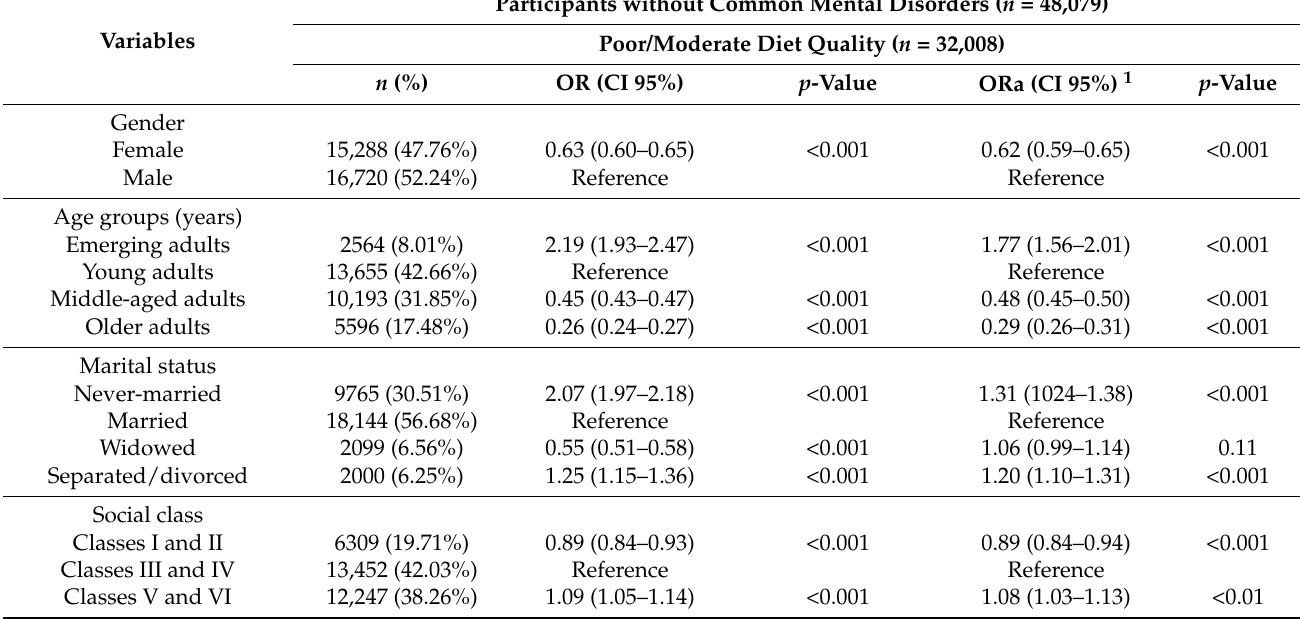
Table 6. Association between diet quality and sociodemographic, lifestyle and health-related factors in people without common mental disorders ( n = 48,079) (SNHS 2006, SNHS 2011/2012 and SNHS